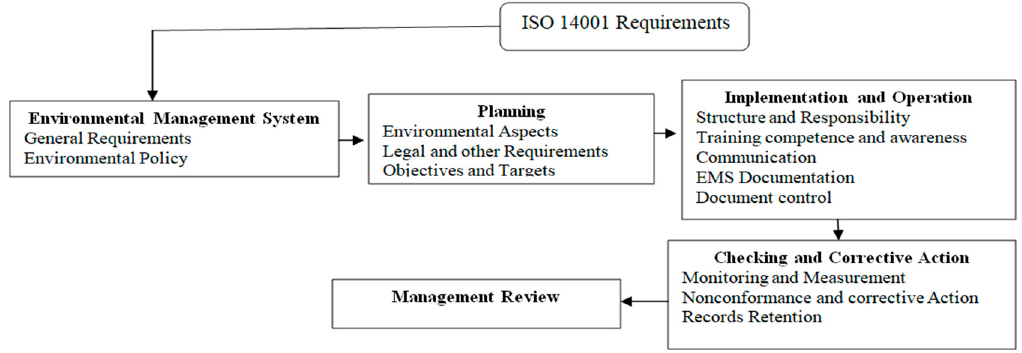
Figure 3. Requirements of ISO 14001.